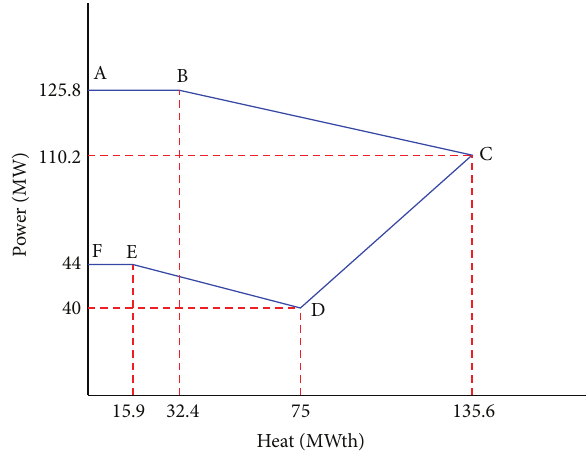
Figure 2: Heat-power feasible operating region for CHP unit